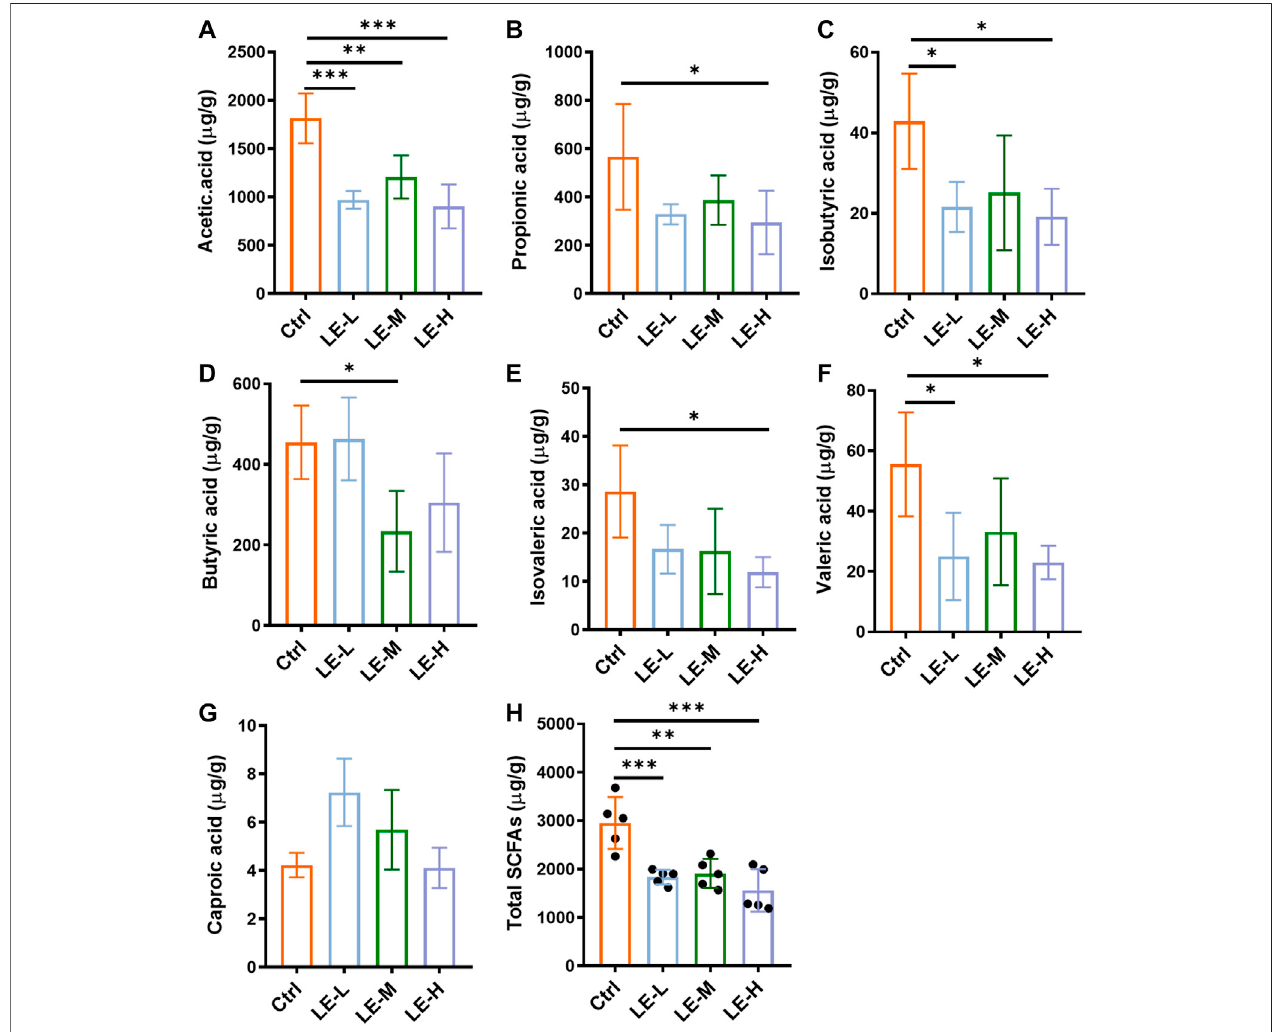
FIGURE3| ExcessivelonganintakealtersSCFAsproduction inmice.Contentsofacetic acid (A) ,propionicacid (B) ,isobutyricacid (C) ,butyricacid (D) ,isovaleric acid (E) , valeric acid (F) , and caproic acid (G) in colonic contents. (H) Total contents of SCFAs. Data are presented as mean ± SD ( n (cid:1) 5). * p < 0.05, ** p < 0.01, *** p < 0.001, compared to